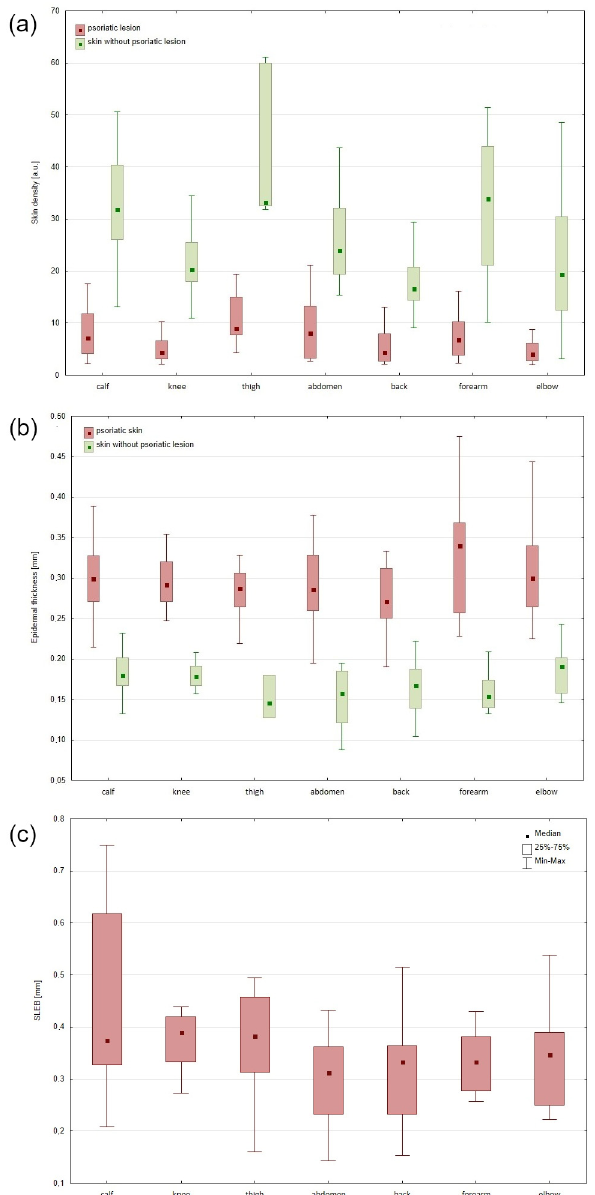
Figure 5. Density of the skin without psoriatic plaques and psoriatic lesion ( a ). Thickness of the epidermis without psoriatic plaques and psoriatic skin: median, interquartile range, min–max ( b ). Thickness of the SLEB determined using high-resolution ultrasound: median, interquartile range, min–max ( c ).